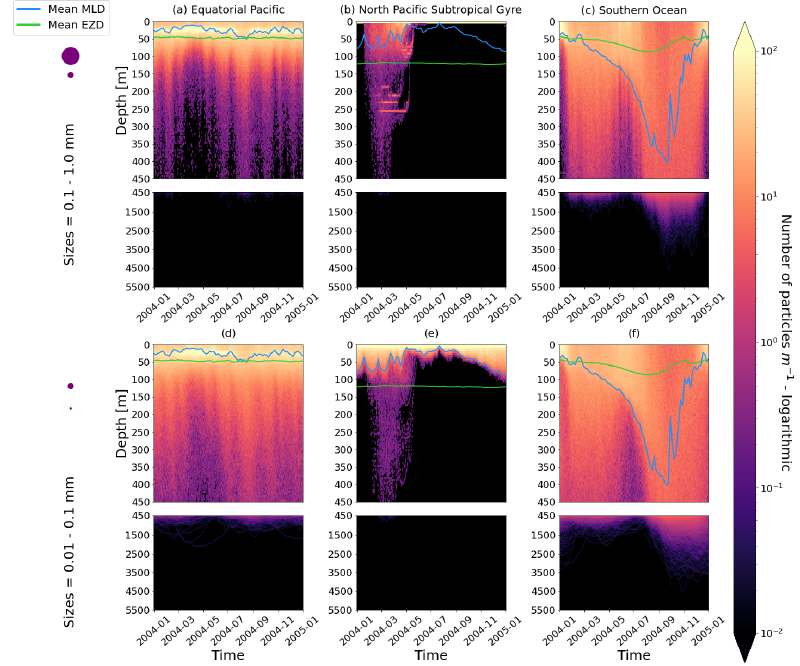
Figure C1. As in Fig. 2 but for particles with an initial density of 30kgm − 3 , representing expandable polystyrene.